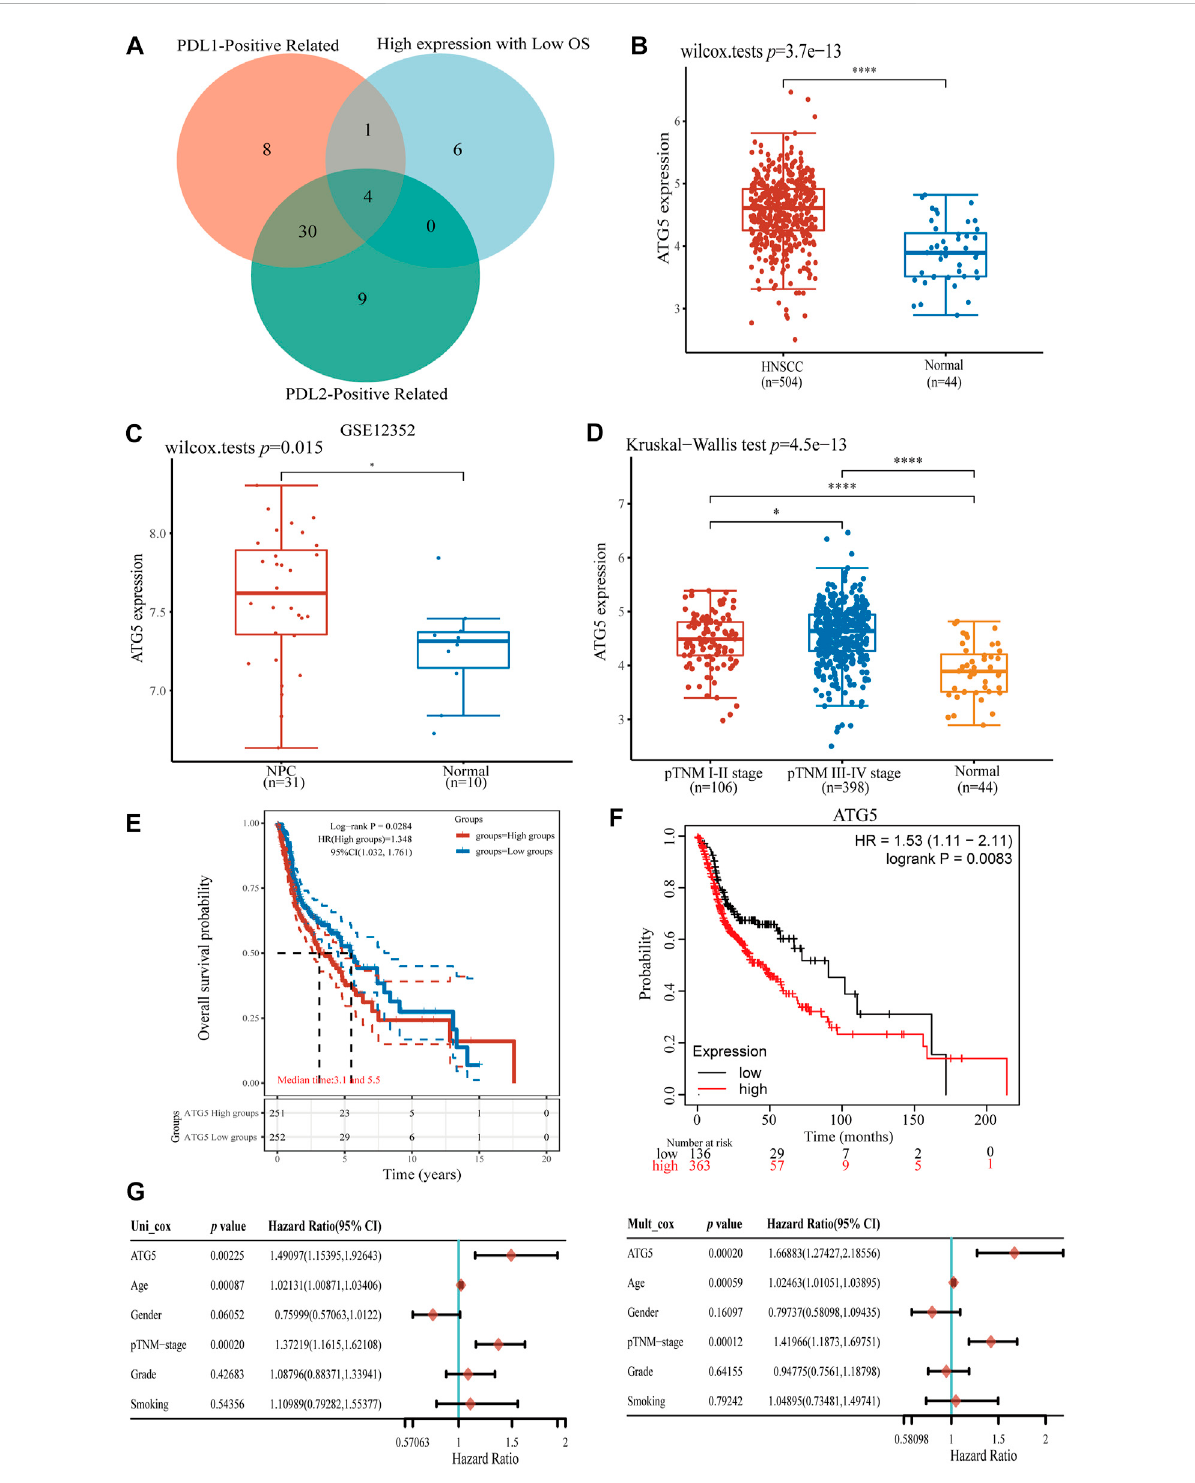
FIGURE 4 Analysis of ferroptosis-related gene ATG5 expression in HNSCC and NPC. (A) The Venn diagram of PD-L1/PD-L2 positive ferroptosis-related gene and high expression with OS in HNSCC samples, four ferroptosis-related genes were conformed. (B) ATG5 gene up-expression in HNSCC samples compared with normal samples. (C) ATG5 gene also highly expressed in NPC GSE12352 dataset (D) Boxplots of expression of ATG5 gene in different stage of HNSCC. (E,F) The Kaplan – Meier analysis of high and low ATG5 expression level in TCGA HNSCC dataset. (G) Forest plots of univariate and multivariate Cox regression of ATG5 expression and other clinicopathological factors. * p < 0.05, ** p < 0.01, *** p <